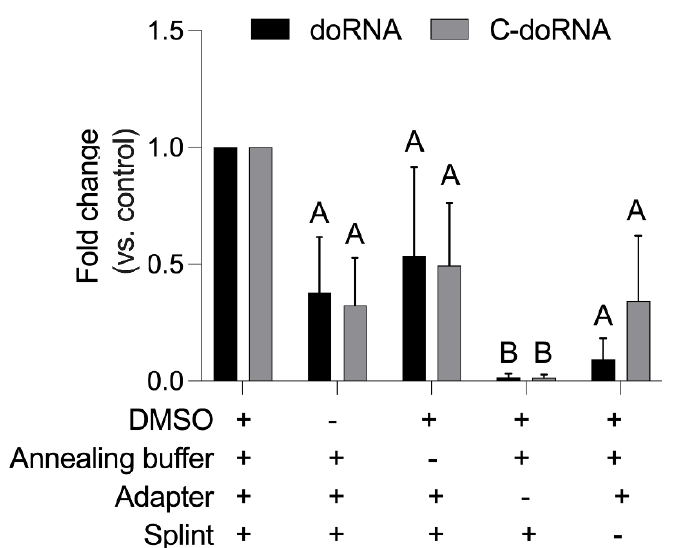
Figure 3. Assessment of the importance of the main reaction medium components. The importance of the essential components of the splinted 5’ ligation buffer was assessed by quantitatively evalu- ating doRNA and C-doRNA detection in their absence (−) or presence (+). Cycle quantitation (Cq) data were normalized on U6 RNA, and the fold changes were calculated versus the optimized buffer condition (control) containing all the components (mean ± SEM; n = 3 independent experiments). The 4:2 splint was used in this experiment. Letters above the bars represent conditions with a nor- malized fold change significantly different from the control: A, p < 0.0260; B, p < 0.0399 (two-way ANOVA with Holm–Sidak’s post hoc test).